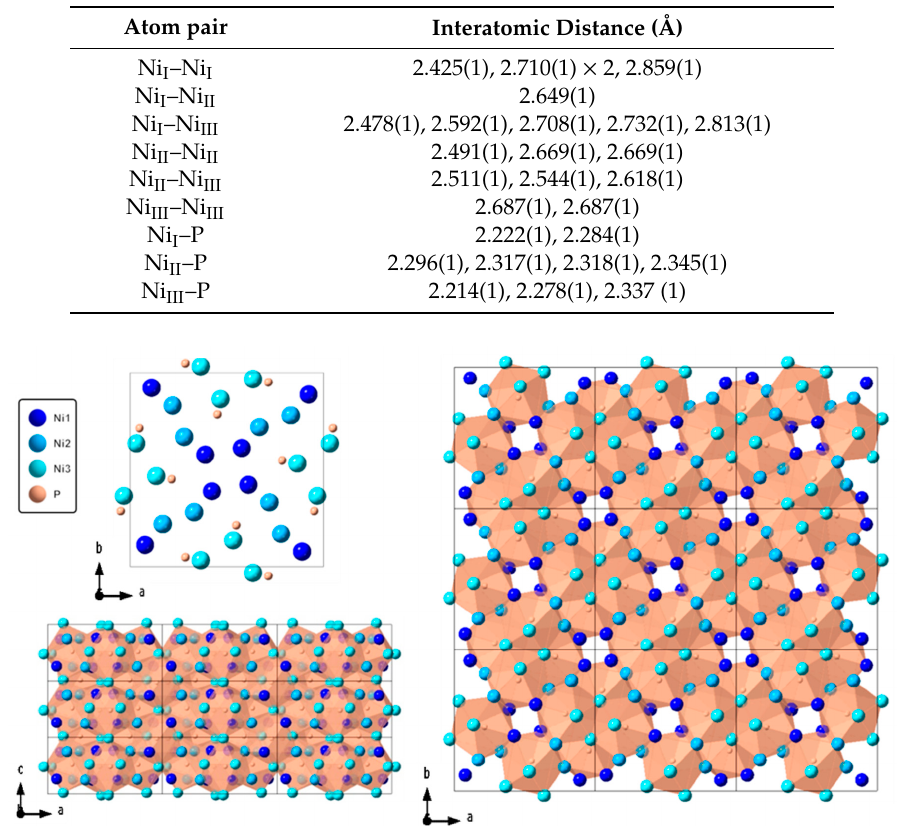
Table 2. Bonding interatomic distances in Ni 3 P at ambient pressure and temperature.